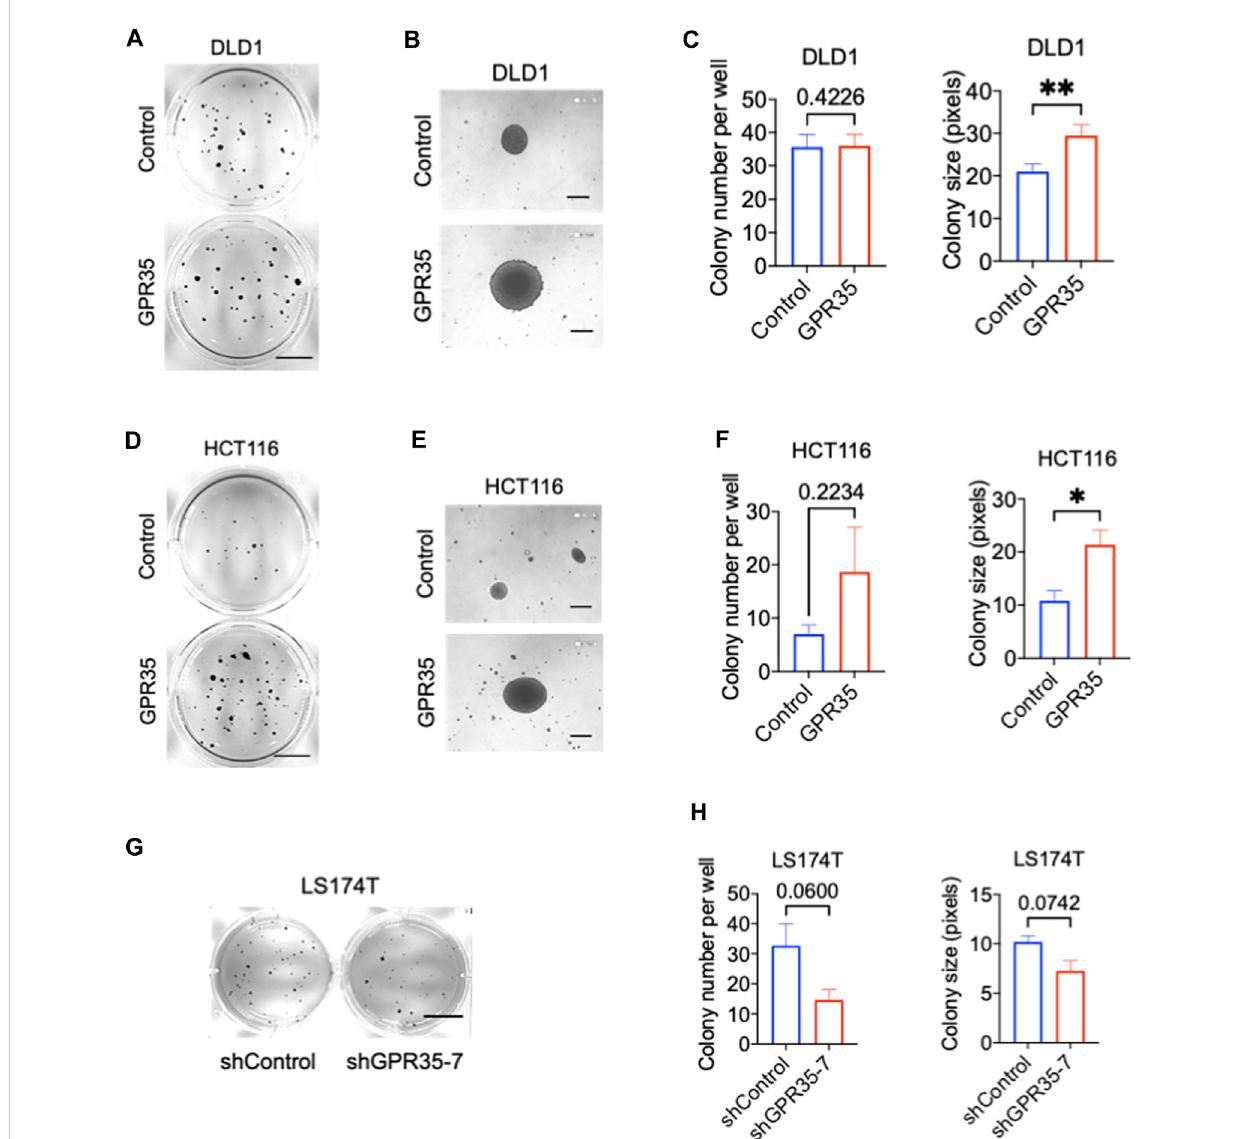
FIGURE 1 GPR35 promoted anchorage-independent growth in CRC cells. (A – C) Representative images of colonies formed by DLD1 cell lines in soft agar in 21 days and quanti fi cation data of soft agar colony formation assay ( n = 3). Scale bars: 1.0 cm. (B) Colonies observed with a microscope. Scale bars: 0.1 mm. (D – F) RepresentativeimagesofcoloniesformedbyHCT116celllinesinsoftagarin21 days,andquanti fi cationdataofsoftagarcolonyformation assay ( n = 3). Scale bars: 1.0 cm. (E) Colonies observed with a microscope. Scale bars: 0.1 cm. (G,H) Representative images of colonies formed by LS174T cell lines in soft agar in 21 days, and quanti fi cation data of soft agar colony formation assay ( n = 3). Scale bars: 1.0